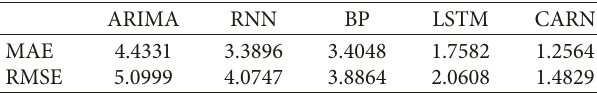
Figure 8: Errors of the prediction results of meteorological forecast data in different methods. Table 4: Error evaluation indicators of the prediction results of meteorological forecast